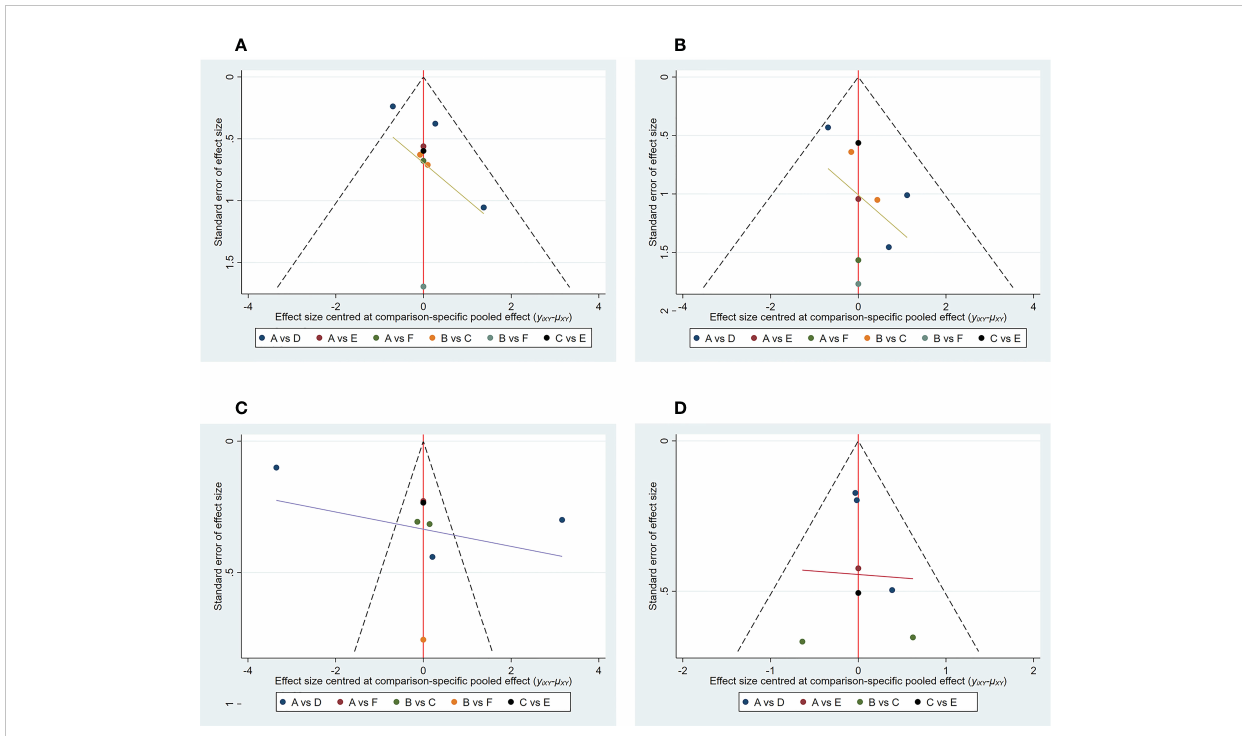
FIGURE 4 Funnel plot of outcome indicators. (A) good response rate; (B) complete response rate; (C) percent change from baseline in SALT score; (D) TEAE (treatment emergent adverse events) rate. A: placebo treatment B: conventional steroid therapy C: any dose of oral tofacitinib treatment D: any dose of oral baricitinib treatment E: any dose of oral ruxolitinib treatment F: nonoral JAK inihibitor treatment.